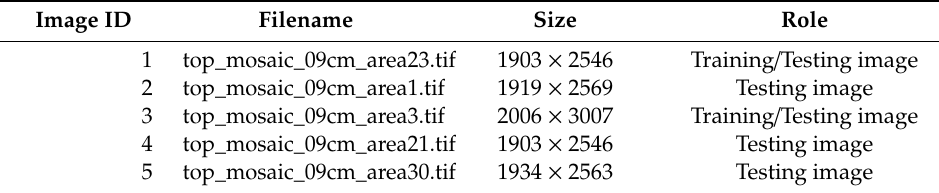
Table 1. Five study images from the Vaihingen